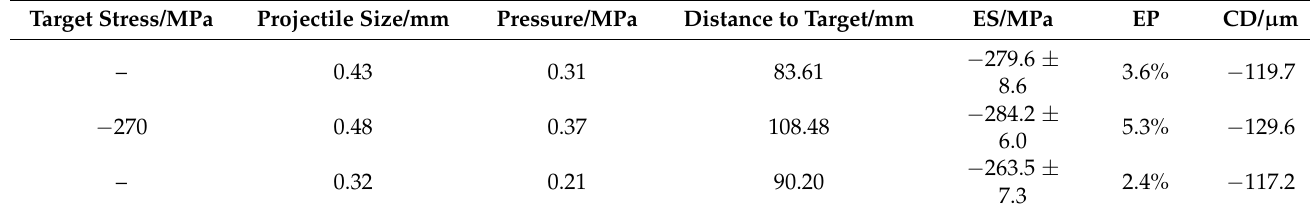
Figure 9. Stress measurement by XRD. Table 6. Comparison of stress between experimental and calculated.